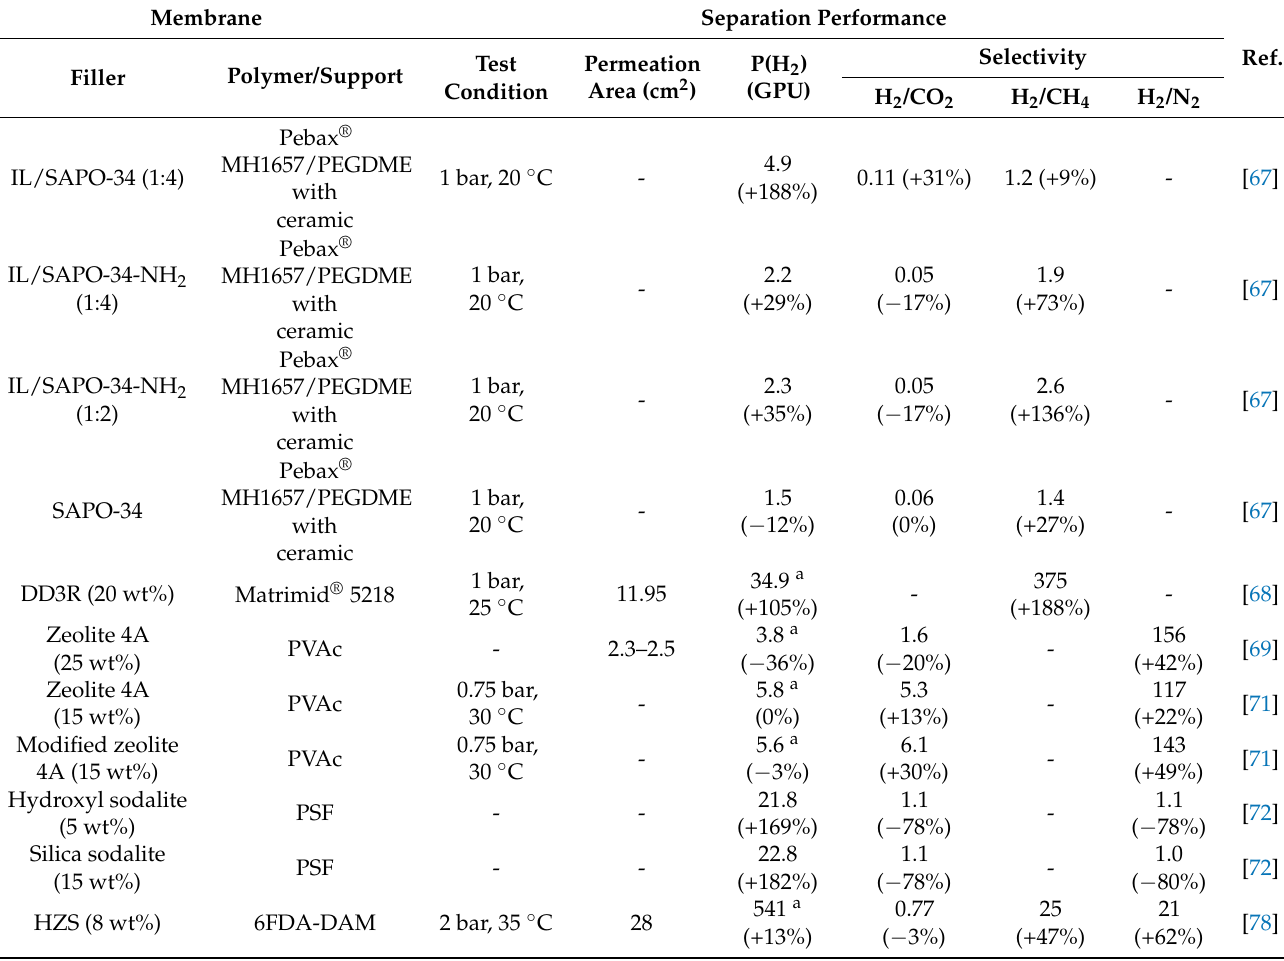
Table 2. Summary of representative performances for zeolite-based membranes in H 2 -based